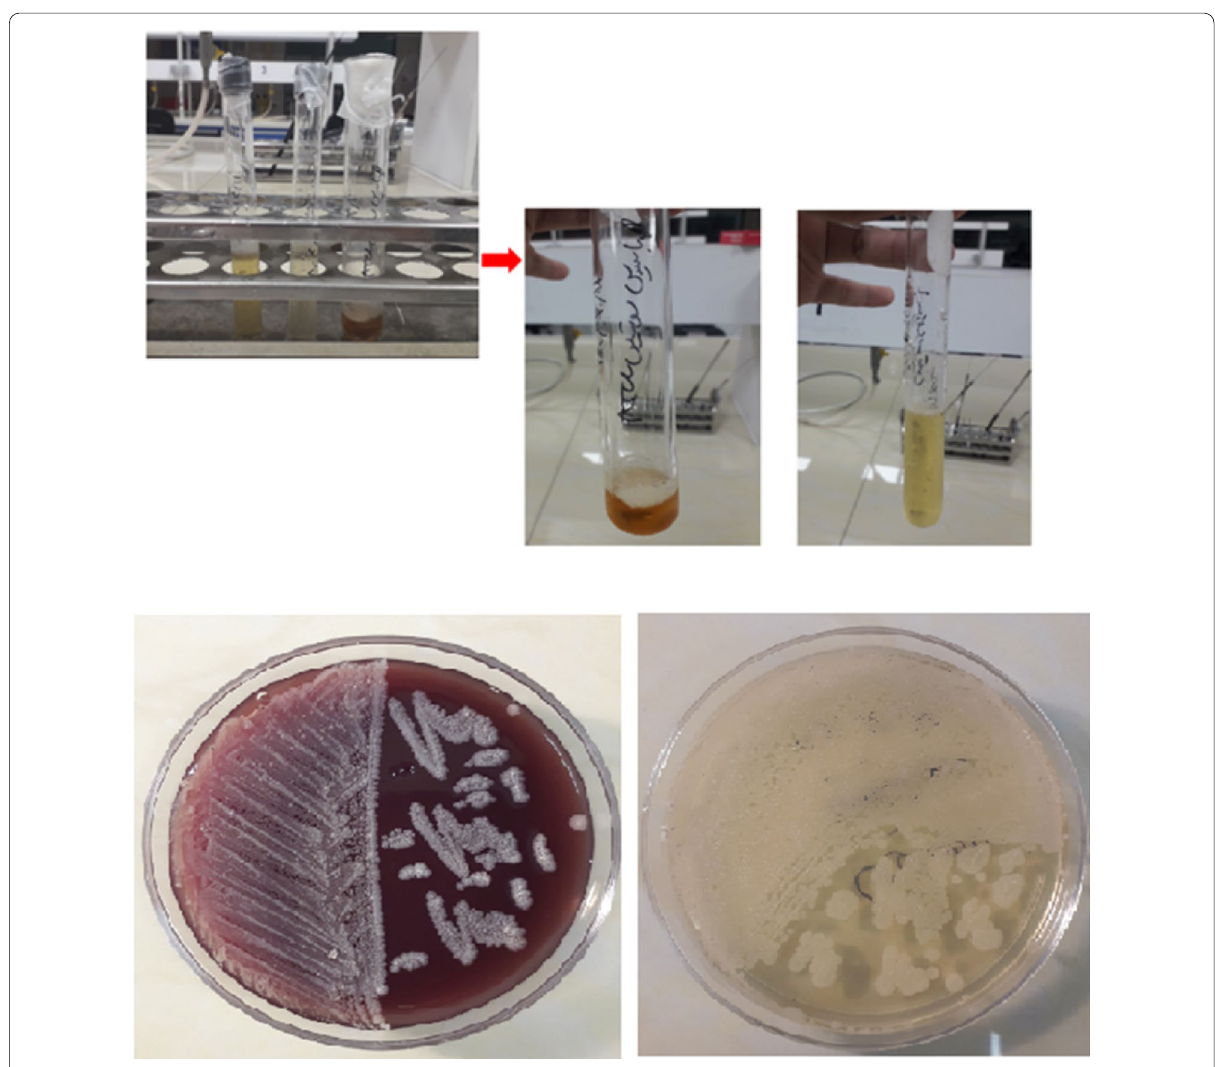
Fig. 1 Removal of the bacteria from the lyophilized phase followed by the plate